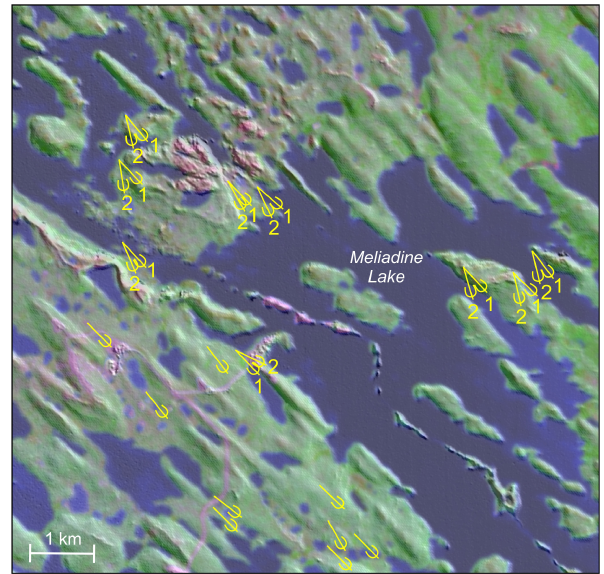
Figure 6. Pattern of striations (yellow arrows) on either side of the Meliadine esker beads, showing convergence towards the esker (no. 2 arrows). Background is a Landsat 8 satellite image (Bands 754) on top of the